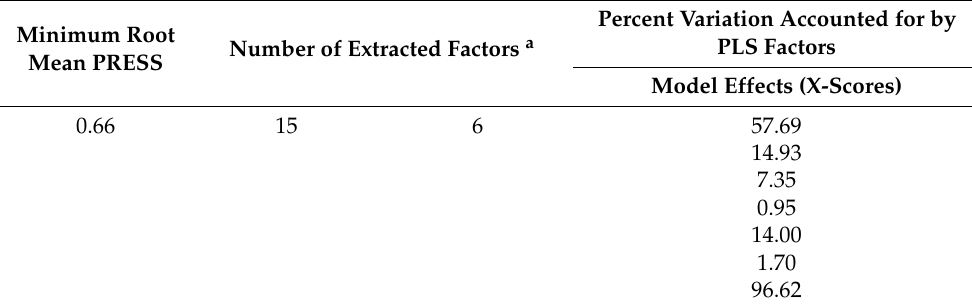
Table 2. Statistics of Partial Least Square (PLS) by pre-processing method, analysis of residuals (normality